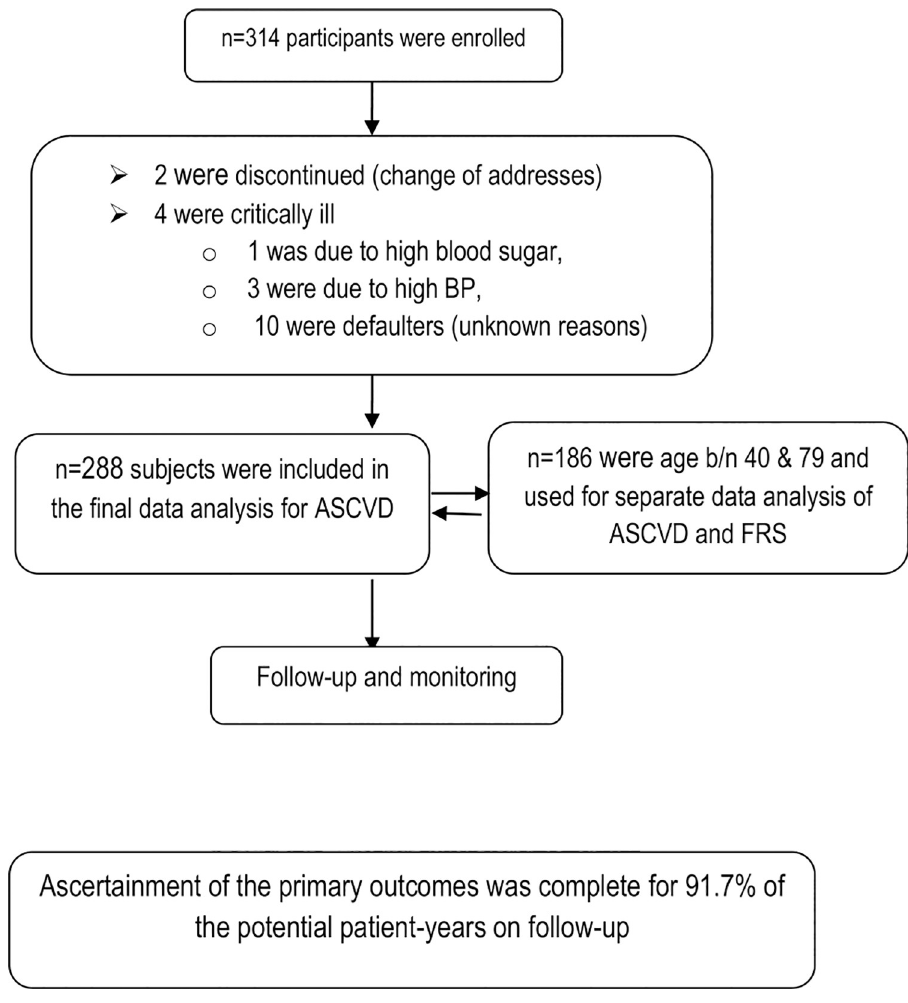
Fig 1. Enrolment, screening and follow